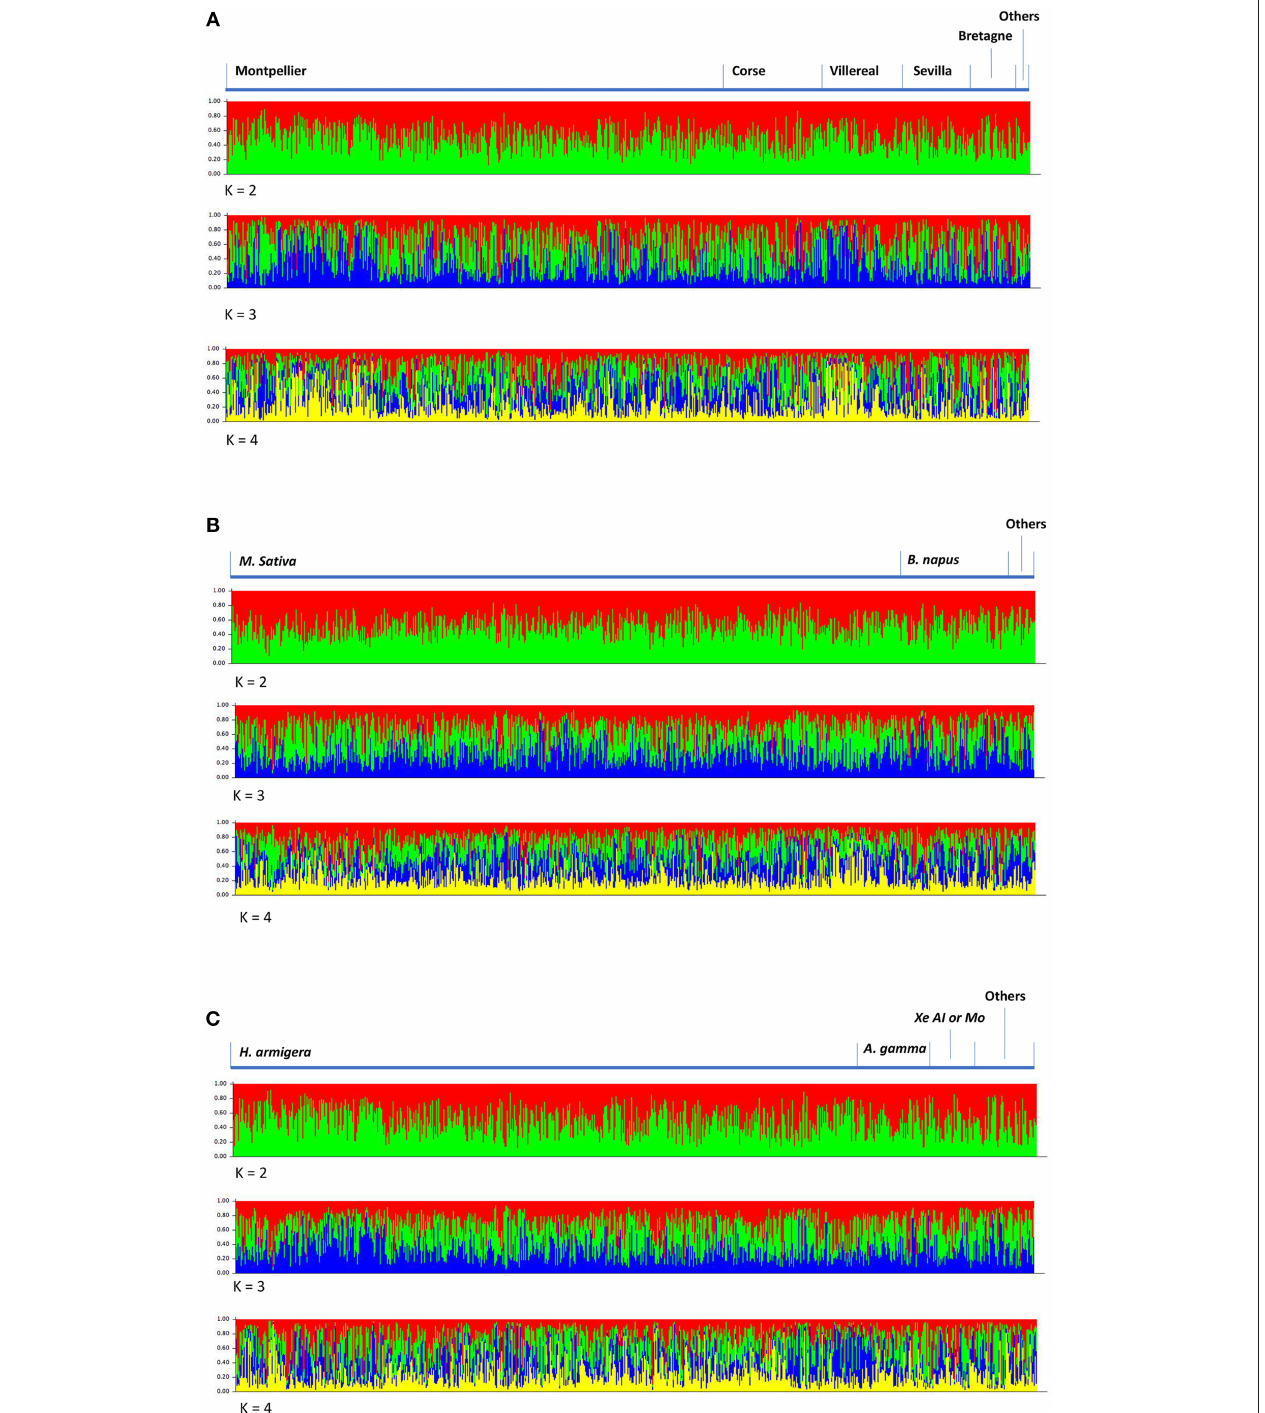
FIGURE 1 | H. didymator population structure from Bayesian STRUCTURE analyses using 14 microsatellite loci for different values of k . Analyses were carried on depending on wasp geographic origin (A) , host plant (B) or host species (C) .